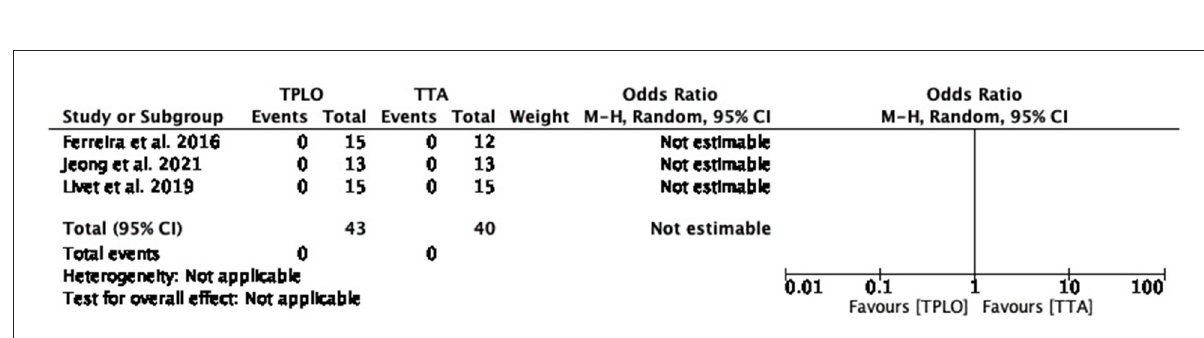
FIGURE4 Forest plot comparing TPLO vs. TTA. Odd ratios (95% CI) of seroma formation as a complication for TPLO and TTA.